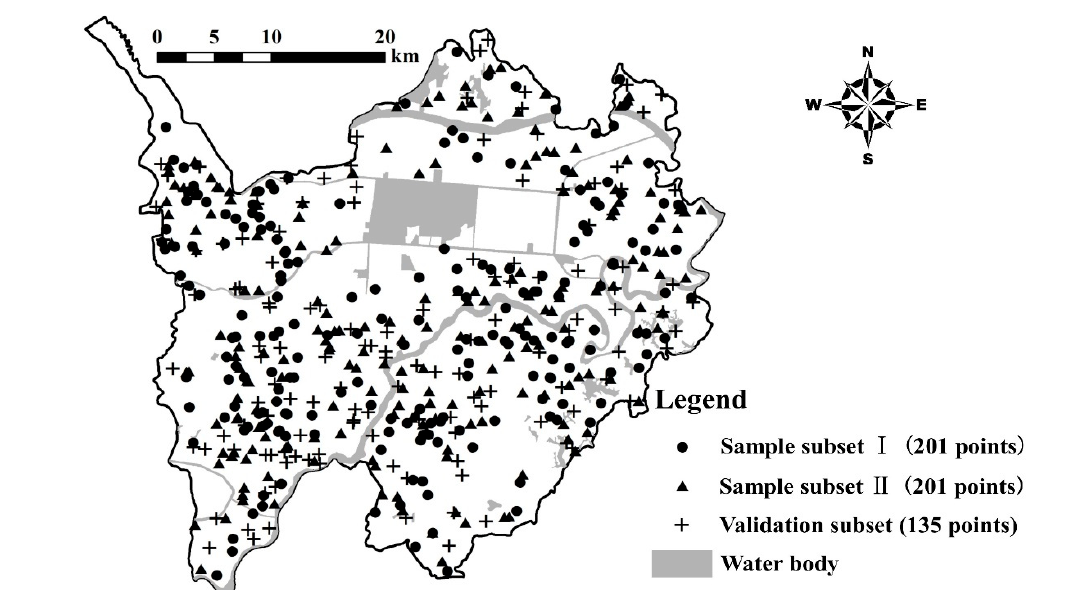
Figure 2. Spatial distribution of the sample subsets: validation subset (TN), sample subset I (TN and SOM), and sample subset II (SOM).